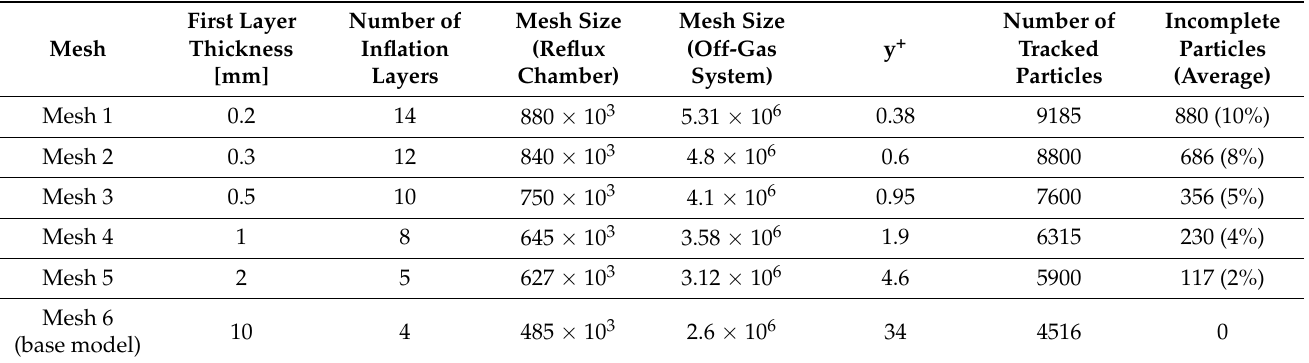
Table 9. Tracked and incomplete particle trajectory for different y + (regardless of turbulent model used)—particle size is fixed and equal to 0.12